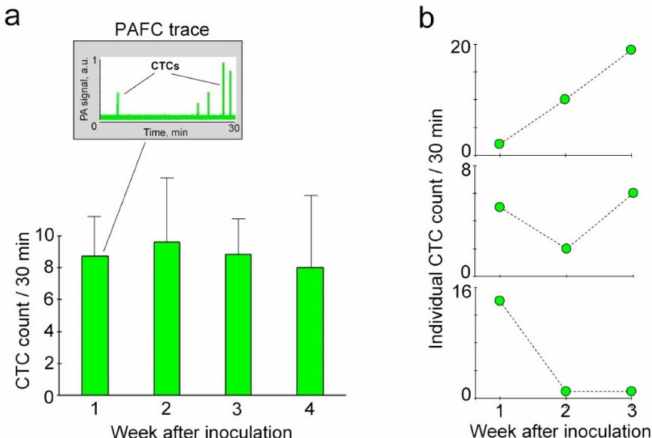
Figure 5. In vivo monitoring of L-CTCs over melanoma progression in groups of mice at week 1 ( n = 33), week 2 ( n = 21), week 3 ( n = 15) and week 4 ( n = 6) after inoculation. ( a ) Average counts of L-CTCs (mean ± SEM), as determined by PAFC; inset: 30-min PAFC trace from the a ff erent lymph in the mouse with early melanoma (week 1 after inoculation). ( b ) Representative examples of individual patterns of L-CTC